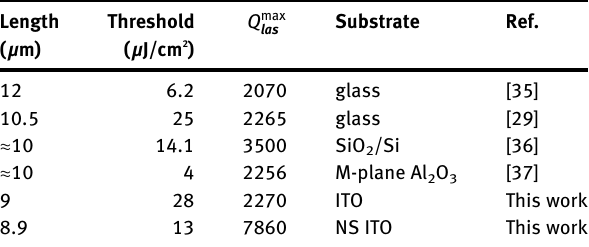
Table  : Optical characteristics of CsPbBr  nanowire lasers of similar length deposited on various substrates.